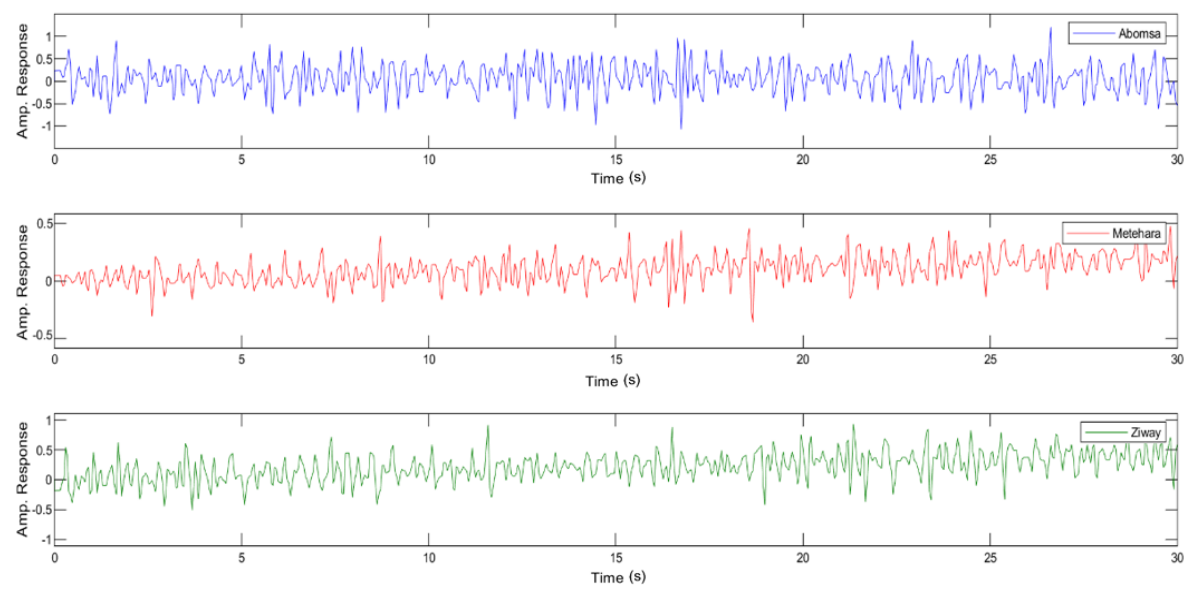
Figure 17. Dynamic response of wind turbine blade for three selected sites.